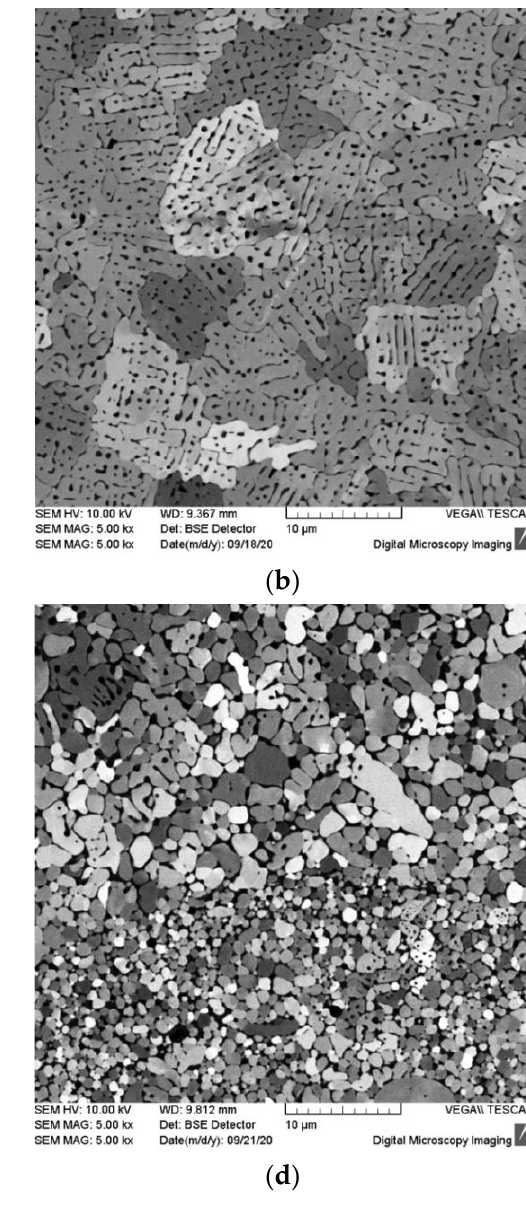
Figure 11. Images of the W-5Ni-2Fe SLM samples structure produced at laser scanning velocity of 300 mm/s ( a , b ) and 900 mm/s ( c , d ) under constant laser power 700 W.